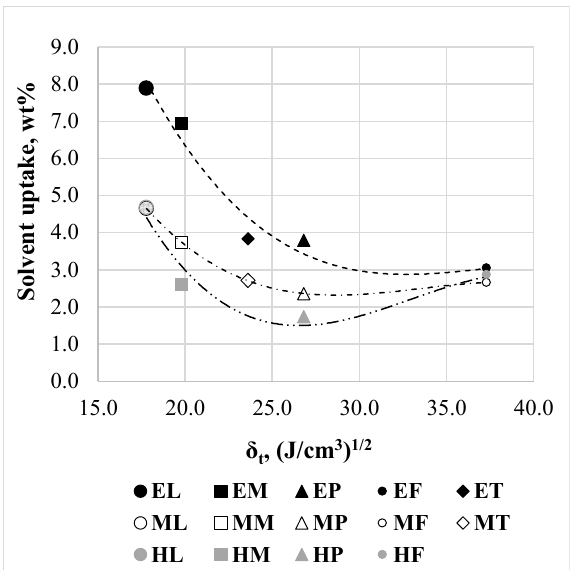
Figure 7. Solvent uptake as a function of the solubility parameter of essential oils in the case of 1.5 wt.% solution concentration with ethanol, methanol and hexane solvent.